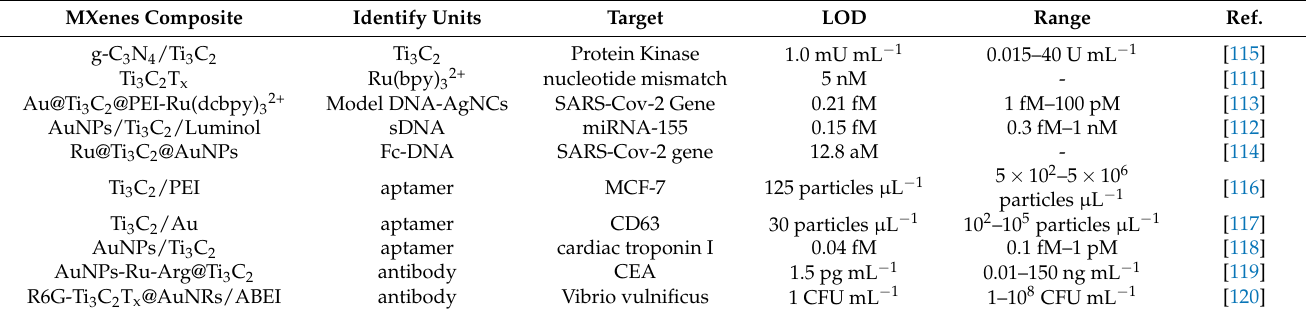
Table 5. MXene-based electrochemiluminescence biosensors identify units, target, and analyti- cal